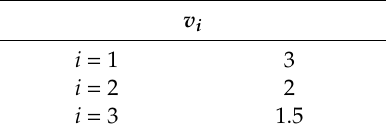
Table A15. Inventory space per unit of product (m 3 ).